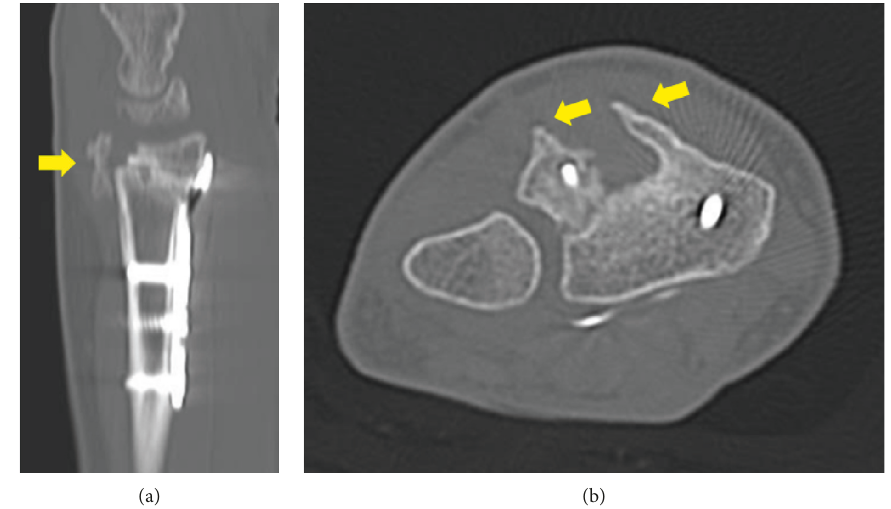
Figure 3: CT scan performed at 6-month follow-up. The arrows show dorsal bone